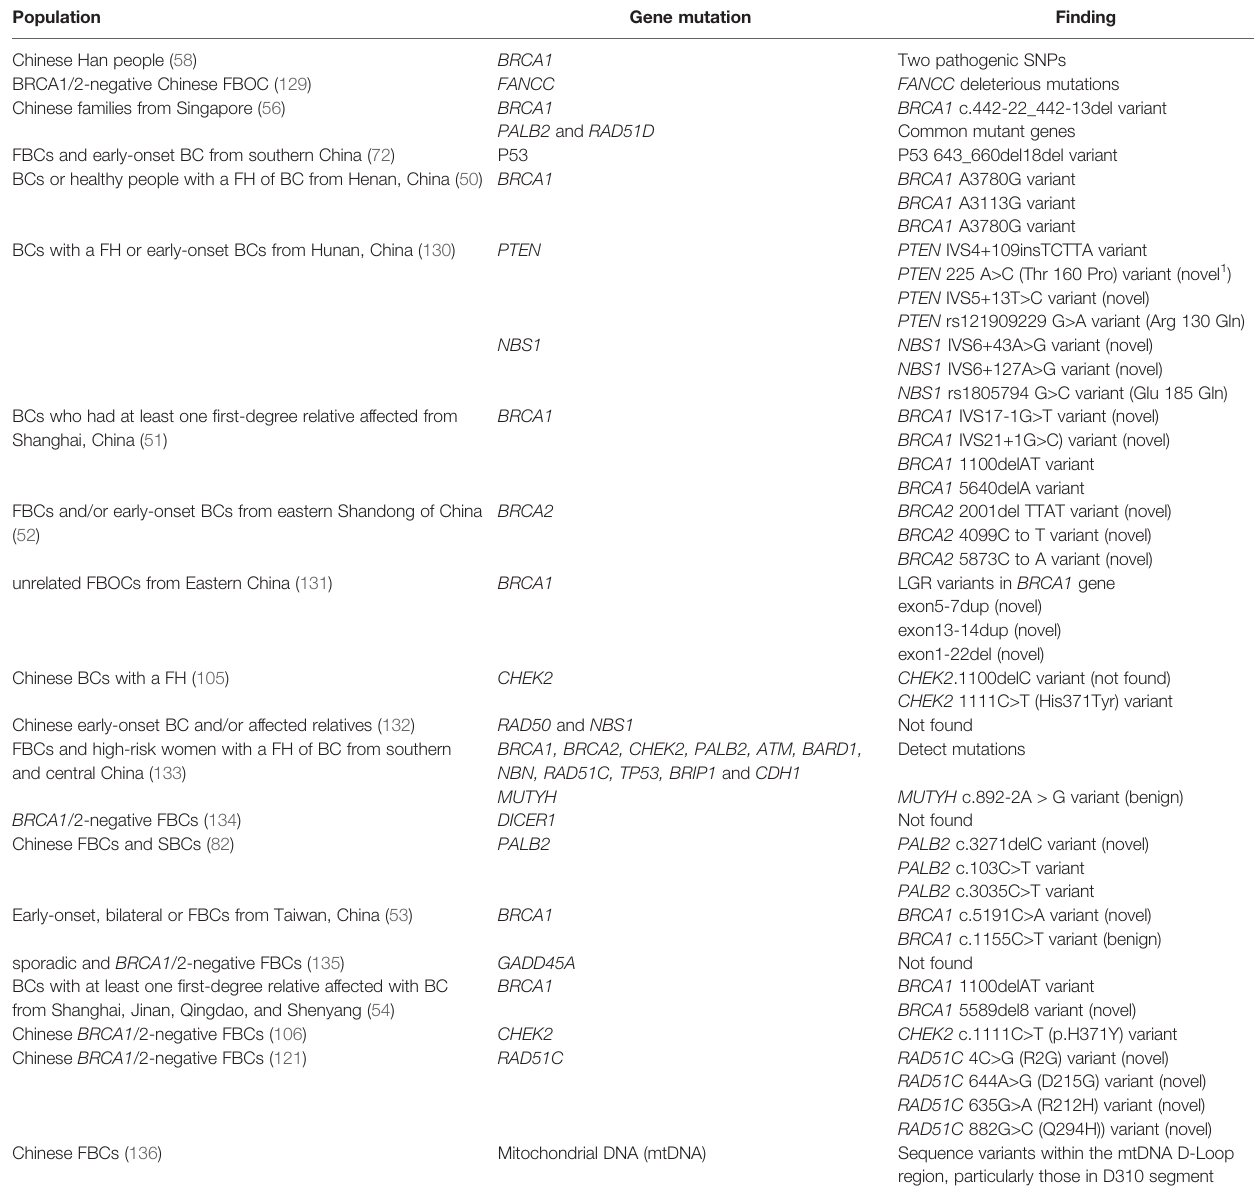
TABLE 2 | Gene mutations in the Chinese